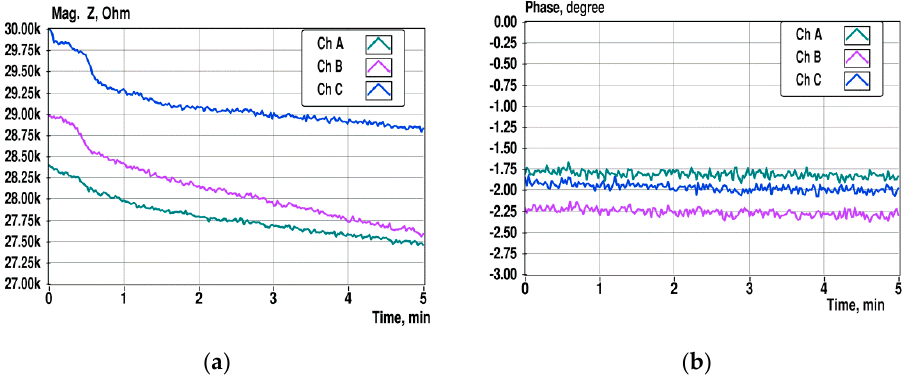
Figure 9. Changes of the impedance magnitude ( a ) and phase ( b ) at 10 kHz during 5 min observation in sensor channels A, B, and C.